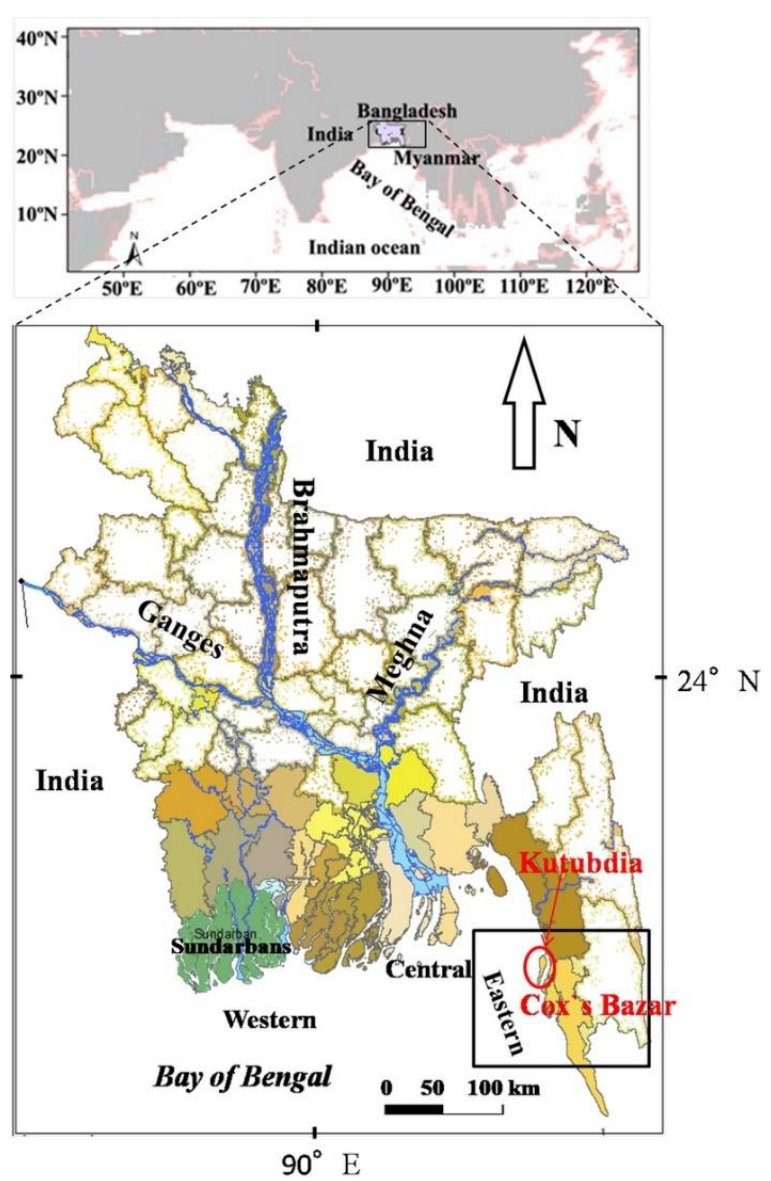
Figure 1. Map of Bangladesh showing the different coastal zones and major river system. Earlier studies showed significant spatial and temporal variation in sea-level trends across different parts (i.e., western, central, and eastern) of the Bangladeshi coast. For example, the rising sea-level trends at Hiron Point (western coast), Char Changa (central coast), and Cox’s Bazar (eastern coast) were found to be 4.0, 6.0, and 7.8 mm/year, respectively, when derived from the tide gauge record of 22 years for the period of 1977–1998 [10]. The rate of sea-level rise is almost double on the eastern coast that on the western coast. The Center for Environmental and Geographic Information